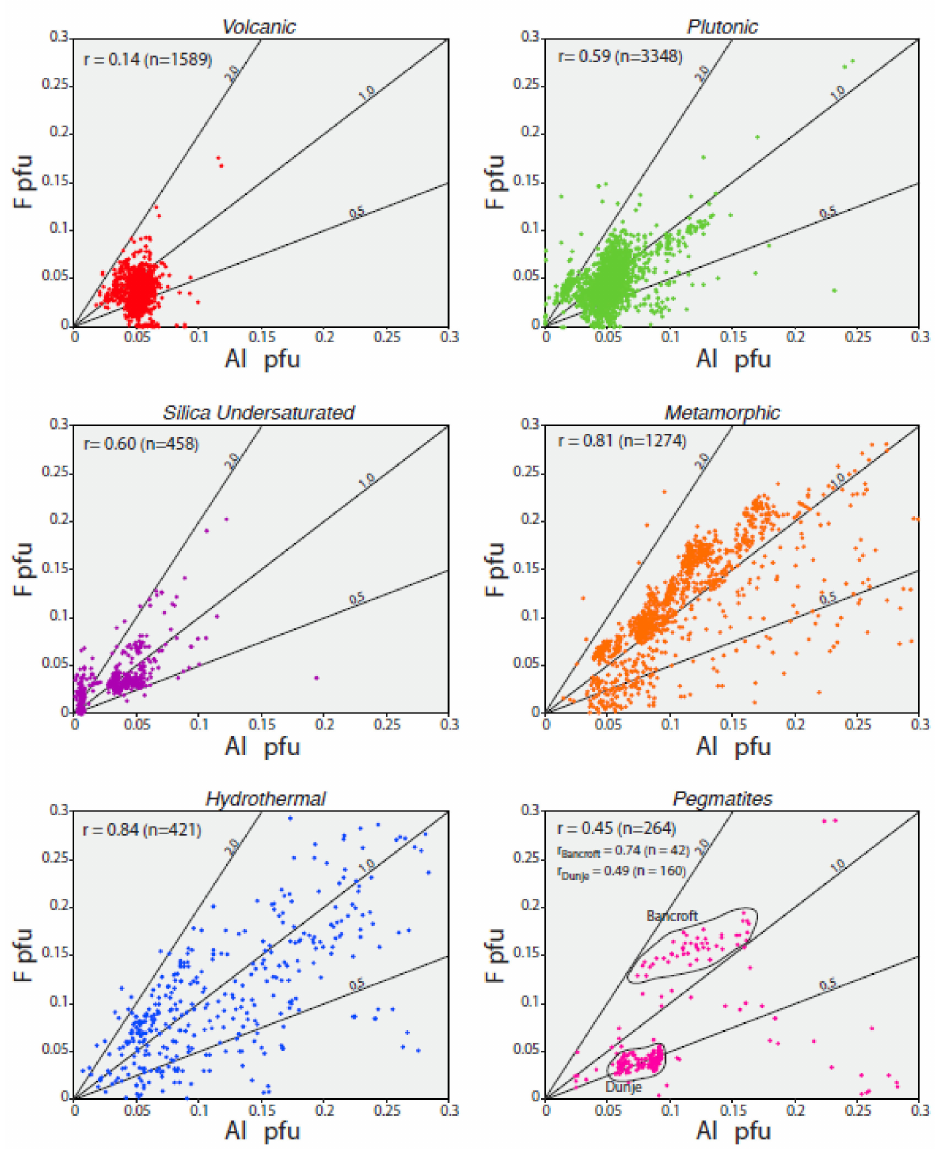
Figure 30. Al versus F in titanite from various environments. The correlation coefficients (r) and number of analyses (n) in each group are shown. Data from two samples constitute most of the points on the pegmatite graph and are enclosed and labeled-Bancroft, Ontario, and Dunje,